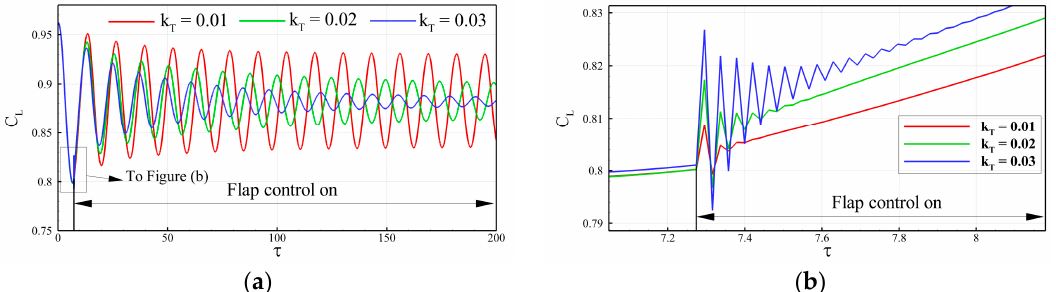
Figure 5. Lift coefficient responses with three different gains at Δτ = 0 . ( a ) C L with control on. ( b ) C L near control start.